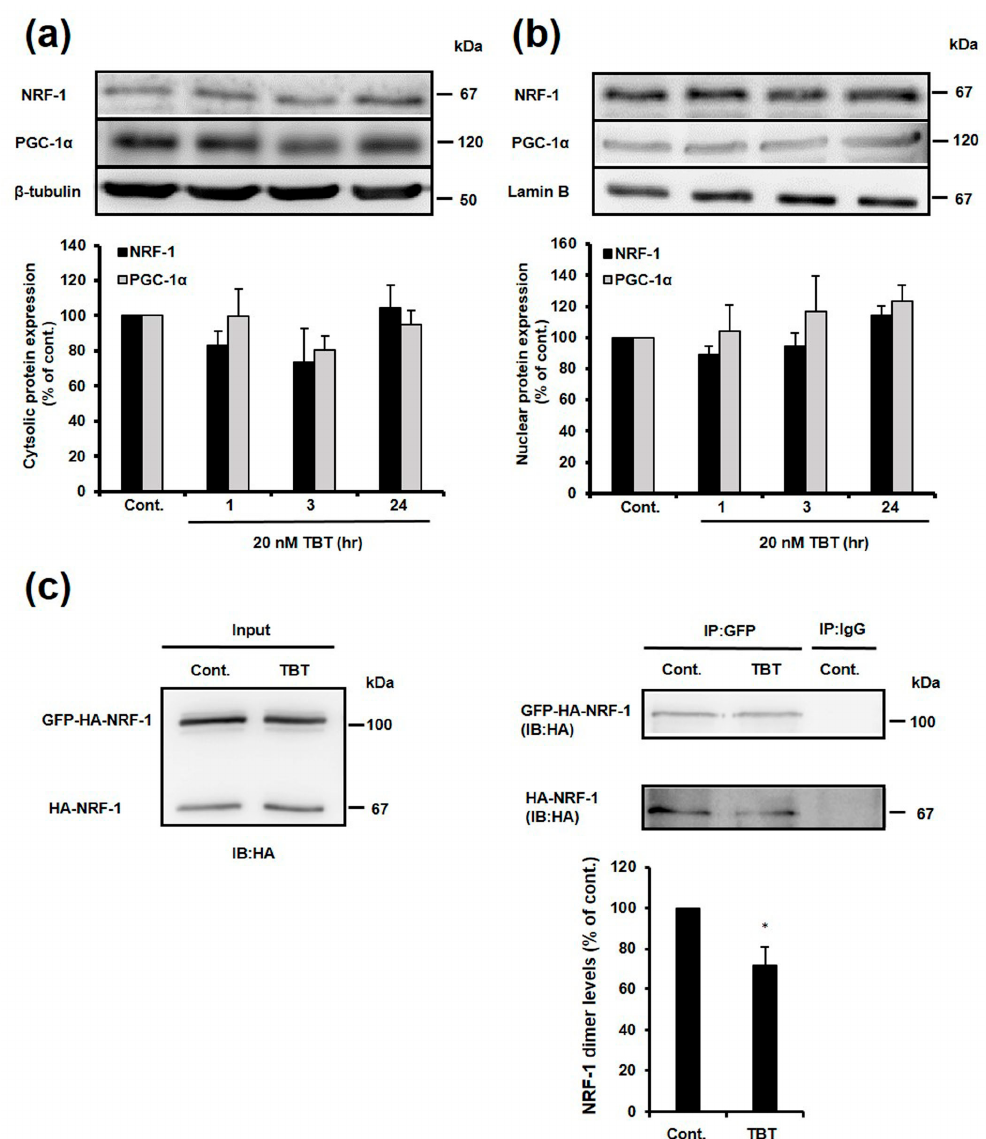
Figure 5. Effect of TBT on NRF-1 and PGC-1 α nuclear translocation. Cytosolic proteins ( a ) and nuclear